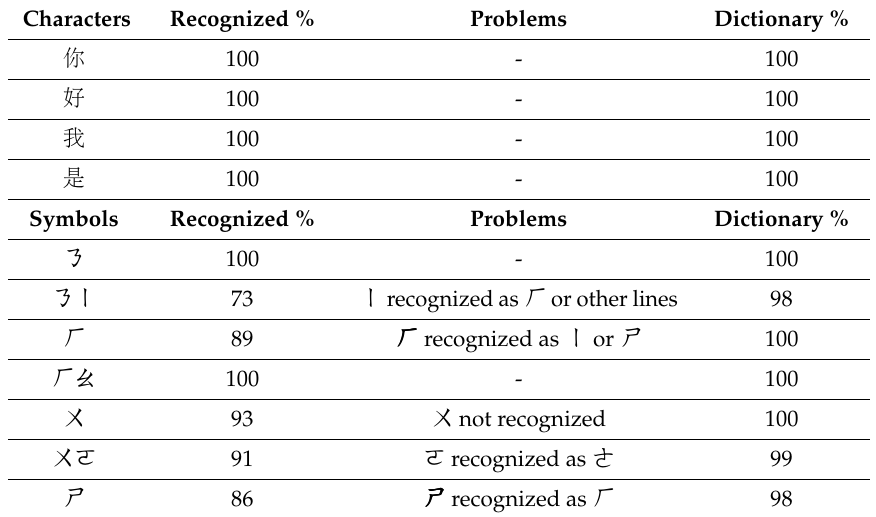
Table 4. Recognition performance of symbols and characters on a smartphone screen (testing times: 100).